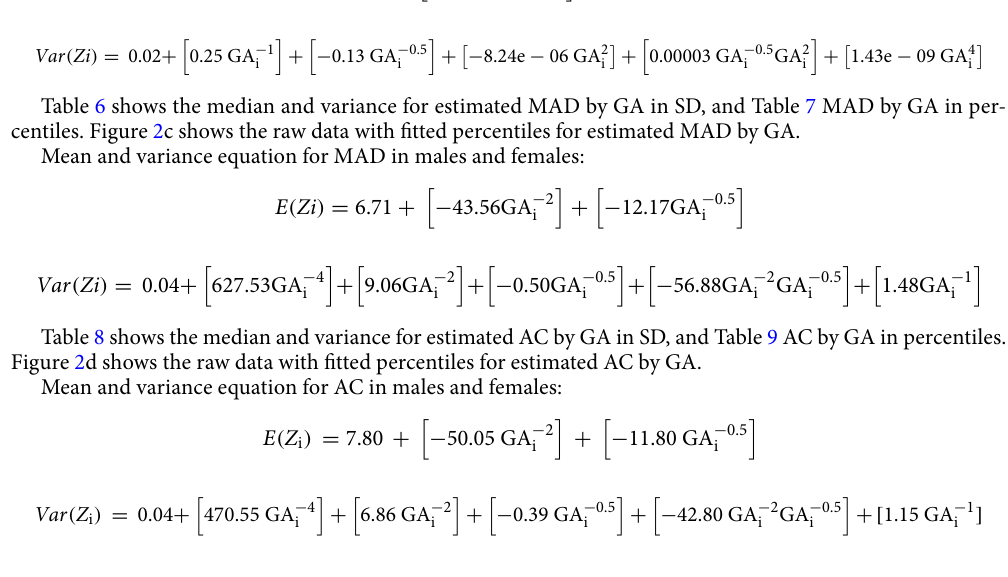
Table 6 shows the median and variance for estimated MAD by GA in SD, and Table 7 MAD by GA in per- centiles. Figure 2c shows the raw data with fitted percentiles for estimated MAD by GA. Mean and variance equation for MAD in males and females: